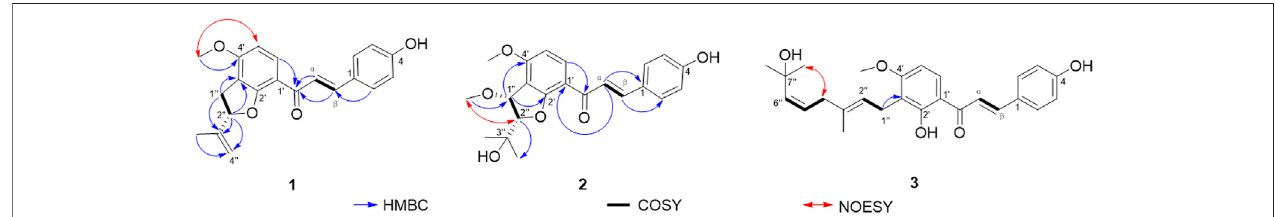
Frontiers in Pharmacology |